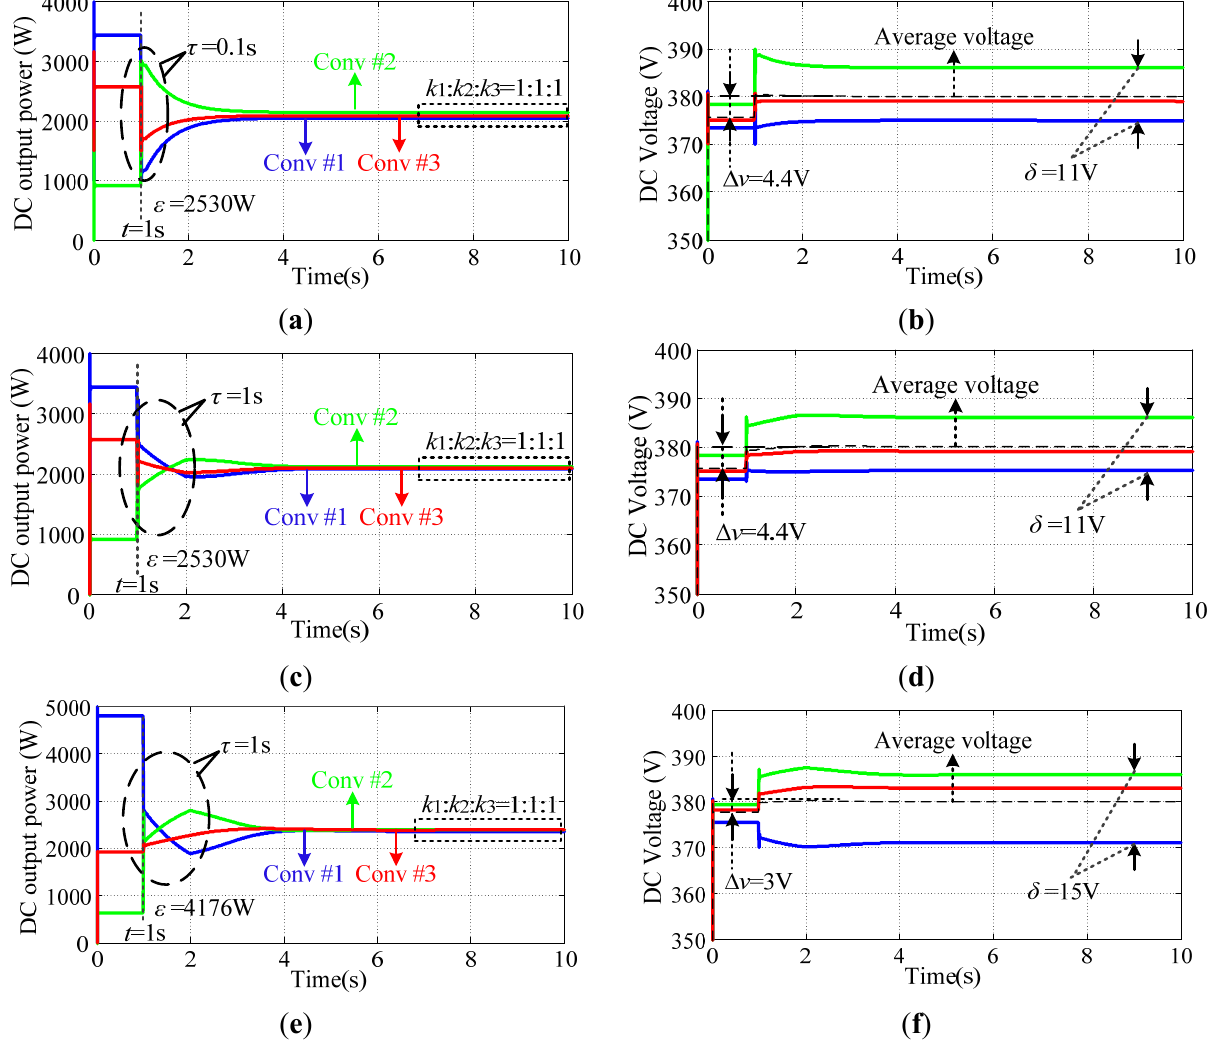
Figure 6. Transient responses for mesh configuration in the DC microgrid. ( a ) Case 1, Power sharing accuracy; ( b ) Case 1, Voltage restoration; ( c ) Case 2, Power sharing accuracy; ( d ) Case 2, Voltage restoration; ( e ) Case 3, Power sharing accuracy; ( f ) Case 3, Voltage